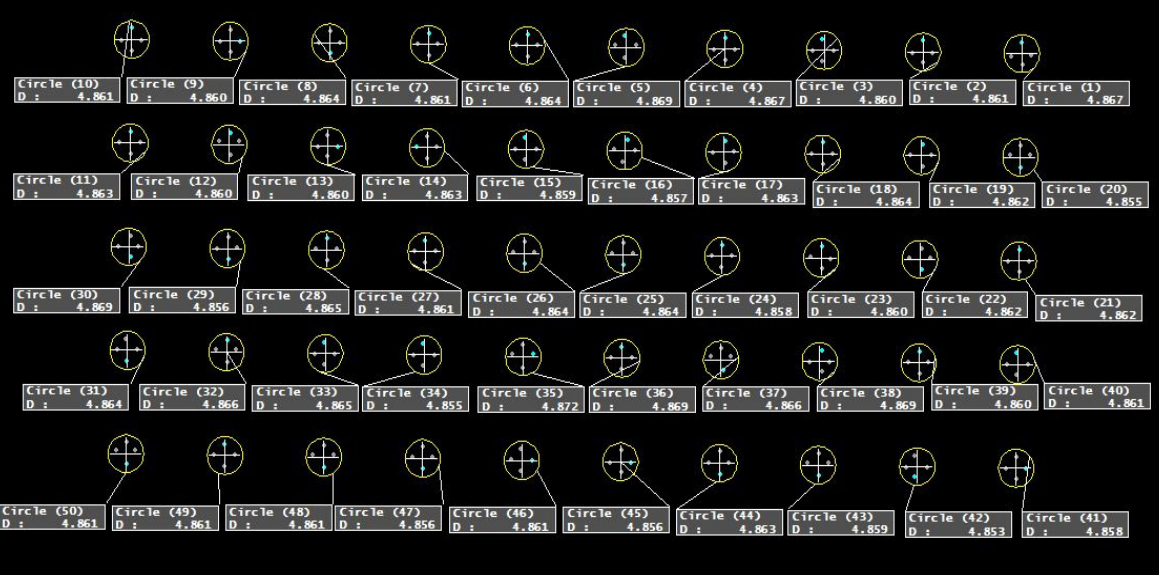
Figure 6. Example of hole diameter measurement for Al7075 − T6 panel.